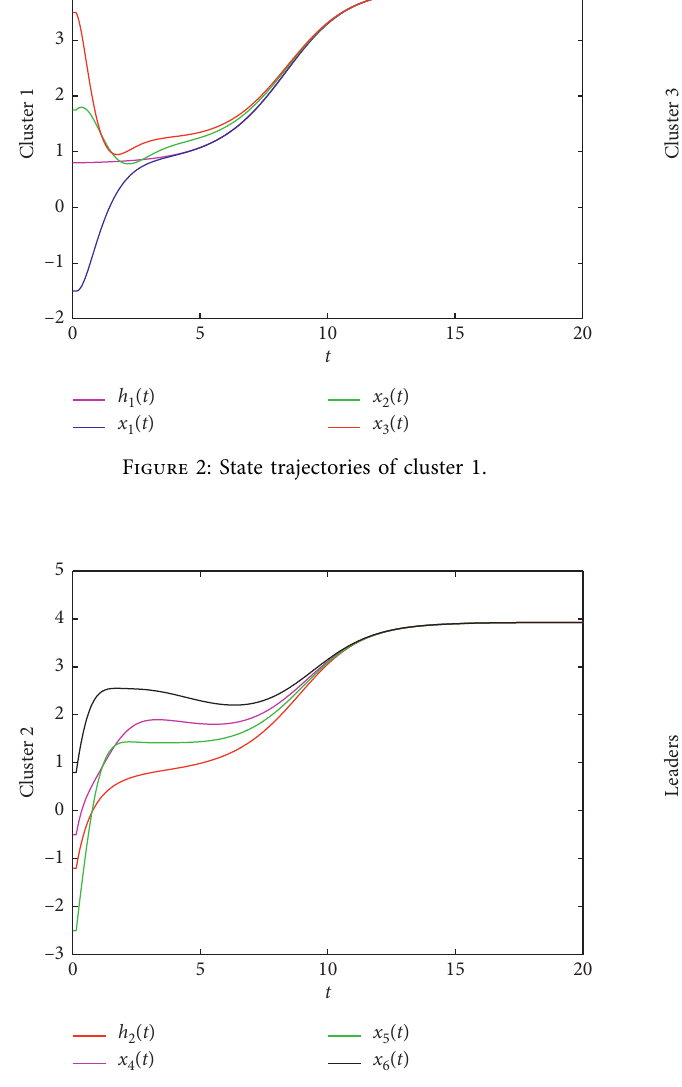
Figure 3: State trajectories of cluster 2.